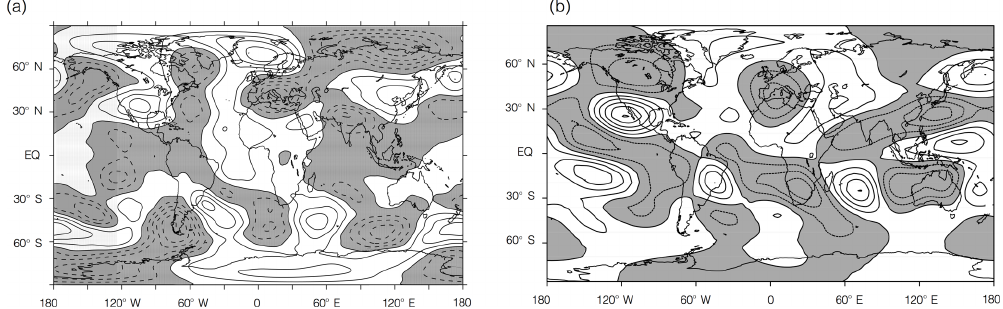
Figure 8. (a) The (1998–2012) vs. 1979–1993) difference in 250hPa stationary waves in HadGEM3-GC2. (b) The 250hPa stationary wave pattern from LUMA when driven by the global HadGEM3-GC2 precipitation anomaly. In both panels, grey shading and dashed contours indicate negative anomalies, white shading and solid contours indicate positive